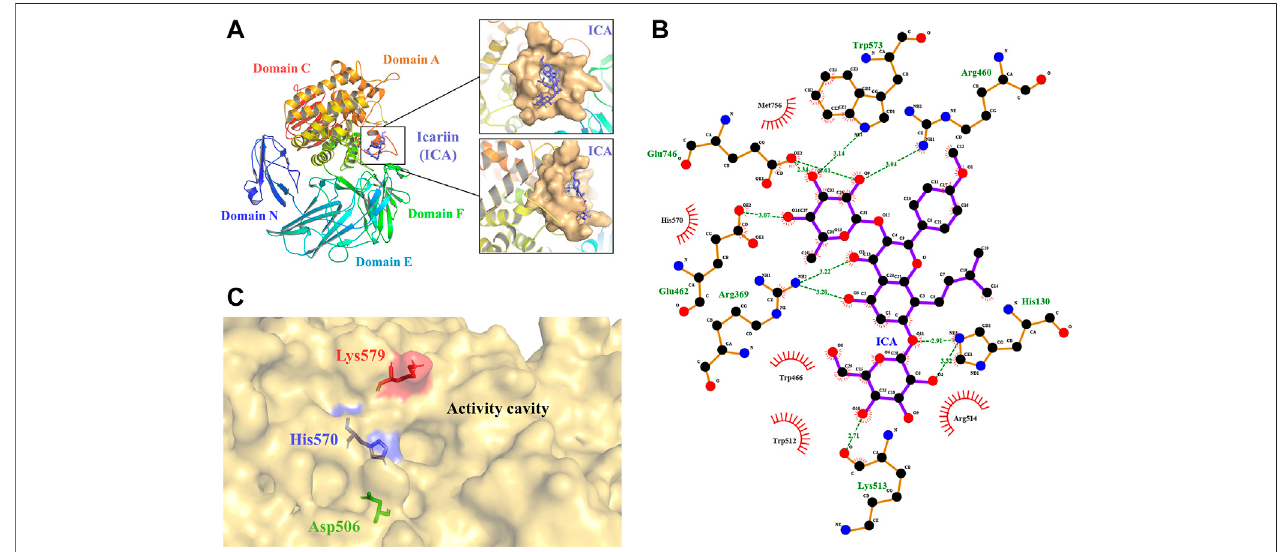
FIGURE 1 | 3D model of TpeRha and docking result of TpeRha and icariin. (A) The overall fold of the TpeRha model. Five distinct domains are shown in different colors (Domain N-blue, Domain E-cyan, Domain F-green, Domain A-orange, and Domain C-red). The LBP of the TpeRha is shown in the magni fi ed area, the LBP displayedasthesurfacetypeshowninbrightorange,andtheligandicariin(ICA)displayedasthestickstypeshowninpurple. (B) Thereceptor-ligandinteractionsformed between TpeRha and icariin. The hydrogen bonds (H-bonds) are shown asgreen dashed lines, and the bond lengths are also shown in theschematic. The names oftheresidueshydrogen-bondedtoicariinareshowningreen,andthenamesofnearbyresiduesareshowninblack. (C) Threeresidueswereselectedthatcouldadjust thesizeoftheactivecavitybasedonthedistribution ofresidues neartheactive pocket.TheD506 atthebottom ofthepocketisshown ingreen,theH570attheedgeof the pocket is shown in blue, and the K579 at the surface of the pocket is shown in red.